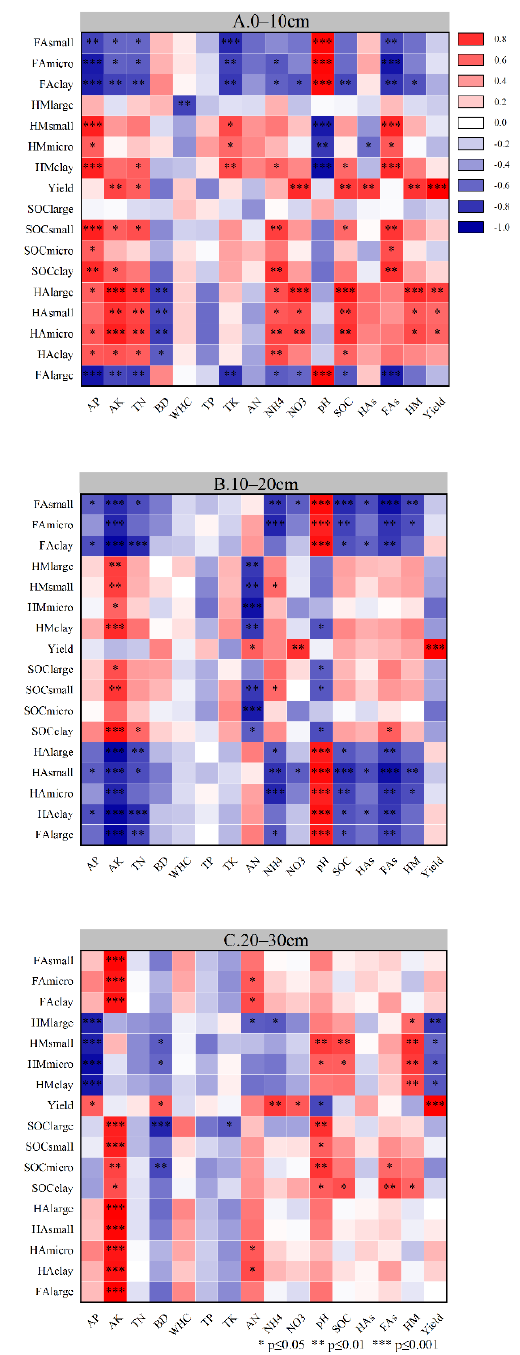
Figure 5. Pearson’s rank correlation coefficients between soil physicochemical properties and aggregates stability and maize grain yield and concentration of humus carbon pool at different depths of the soil layer. ( A ) indicates topsoil (0–10 cm), ( B ) indicates mid-soil (10–20 cm), and ( C ) indicates subsoil (20–30 cm), respectively. (*) Correlation is significant at the 0.05 level; (**) Correlation is significant at the 0.01 level; (***) Correlation is significant at the 0.001 level. BD, bulk density; WHC, field water holding capacity; AN, alkaline nitrogen; AP, available phosphorus; AK, available potassium; TN, total nitrogen; TP, total phosphorus; TK, total potassium; SOC, soil organic carbon; pH, acidity and alkalinity; NH 4 + -N, ammonium nitrogen; NO 3 − -N, nitrate nitrogen; HAs, humic acids; FAs, fulvic acids; HM, humin; large, large-macroaggregate; small, small-macroaggregate; micro, microaggregates; clay, silt and